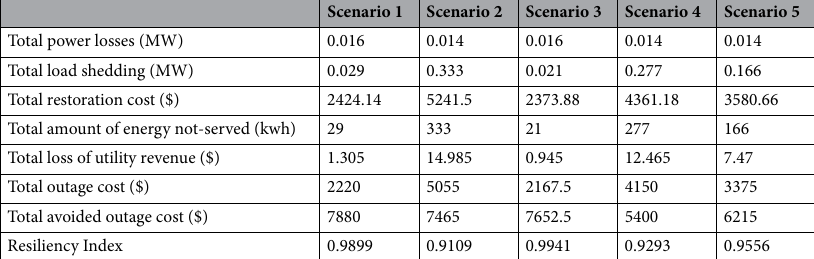
Table 3. Summary of the objectives and resiliency metrics for the five scenarios with EDRP.